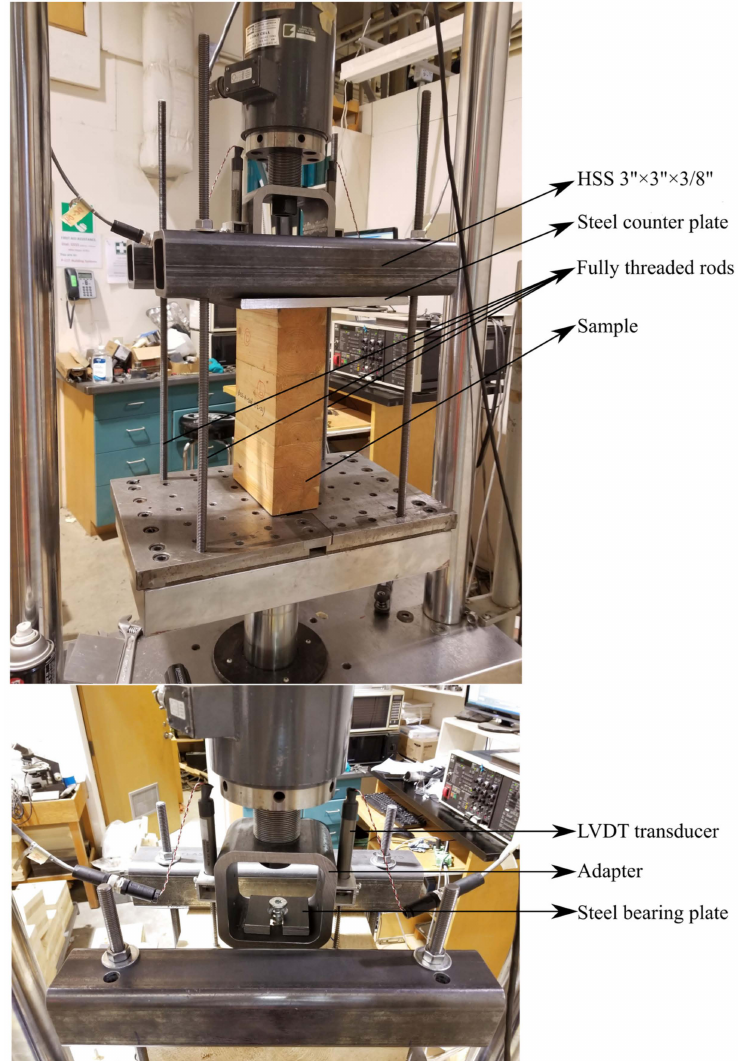
Figure 6. Withdrawal test setup with a trial